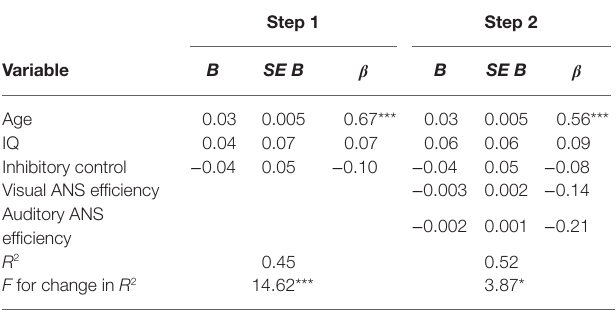
TABLE 2 | Summary of hierarchical linear regression analysis for age, IQ, inhibitory control, and visual and auditory ANS efficiency predicting math ability prior to